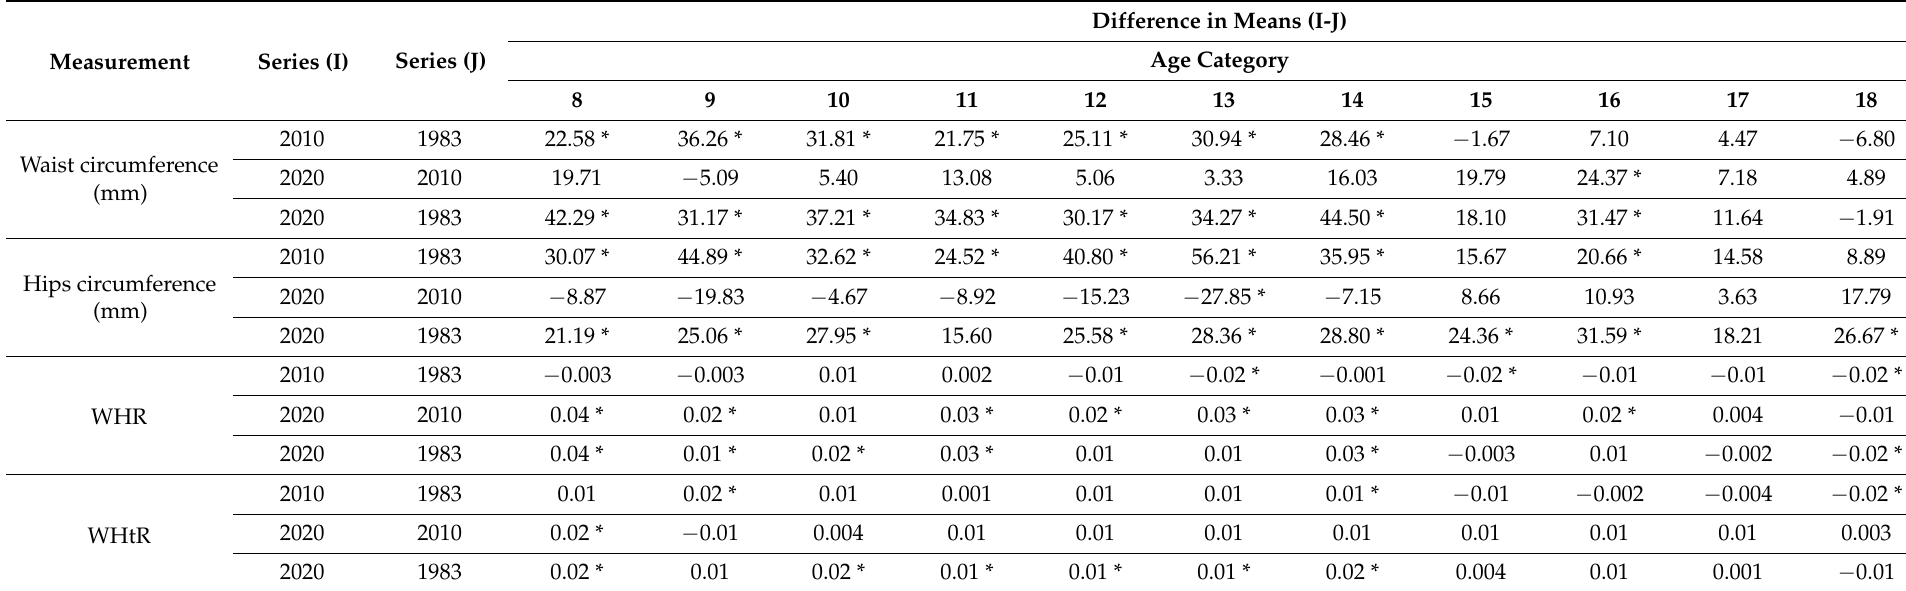
Table 3. Differences between mean values of the analyzed characteristics between cohorts and age categories for